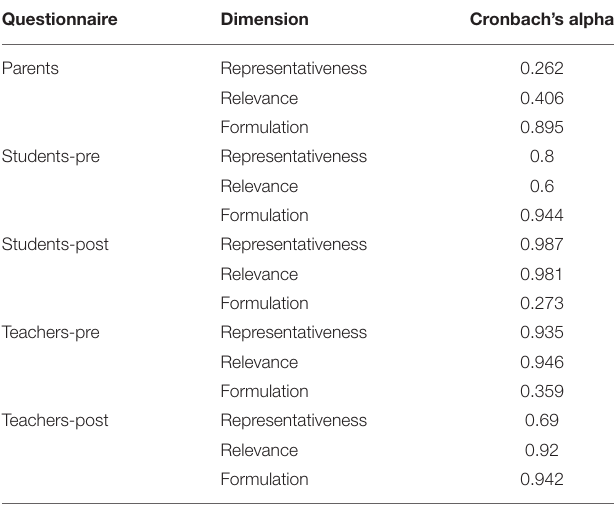
TABLE 3 | Inter-rater reliability (Cronbach’s